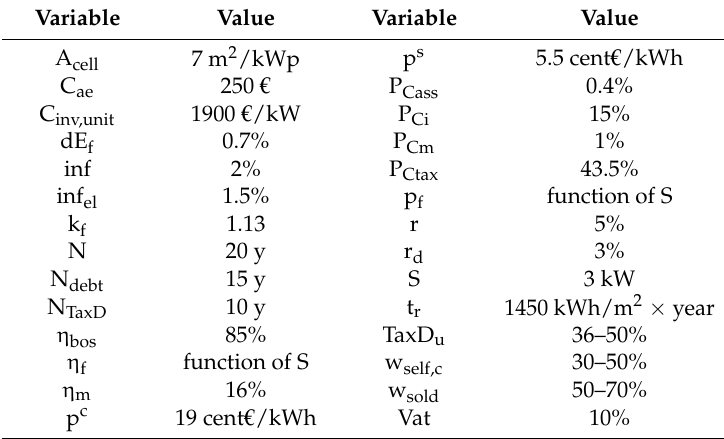
Table 1. Economic inputs (Cucchiella et al. 2017b; Orioli et al.